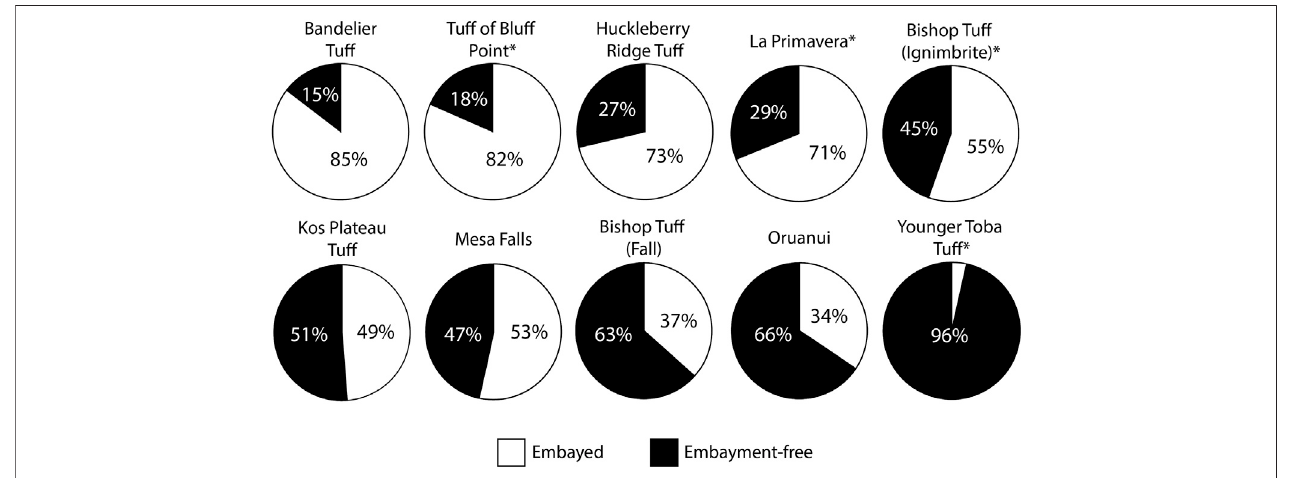
FIGURE 2 | Percentage of crystals with embayments from each eruption. Samples from ignimbrites are indicated with an asterisk.